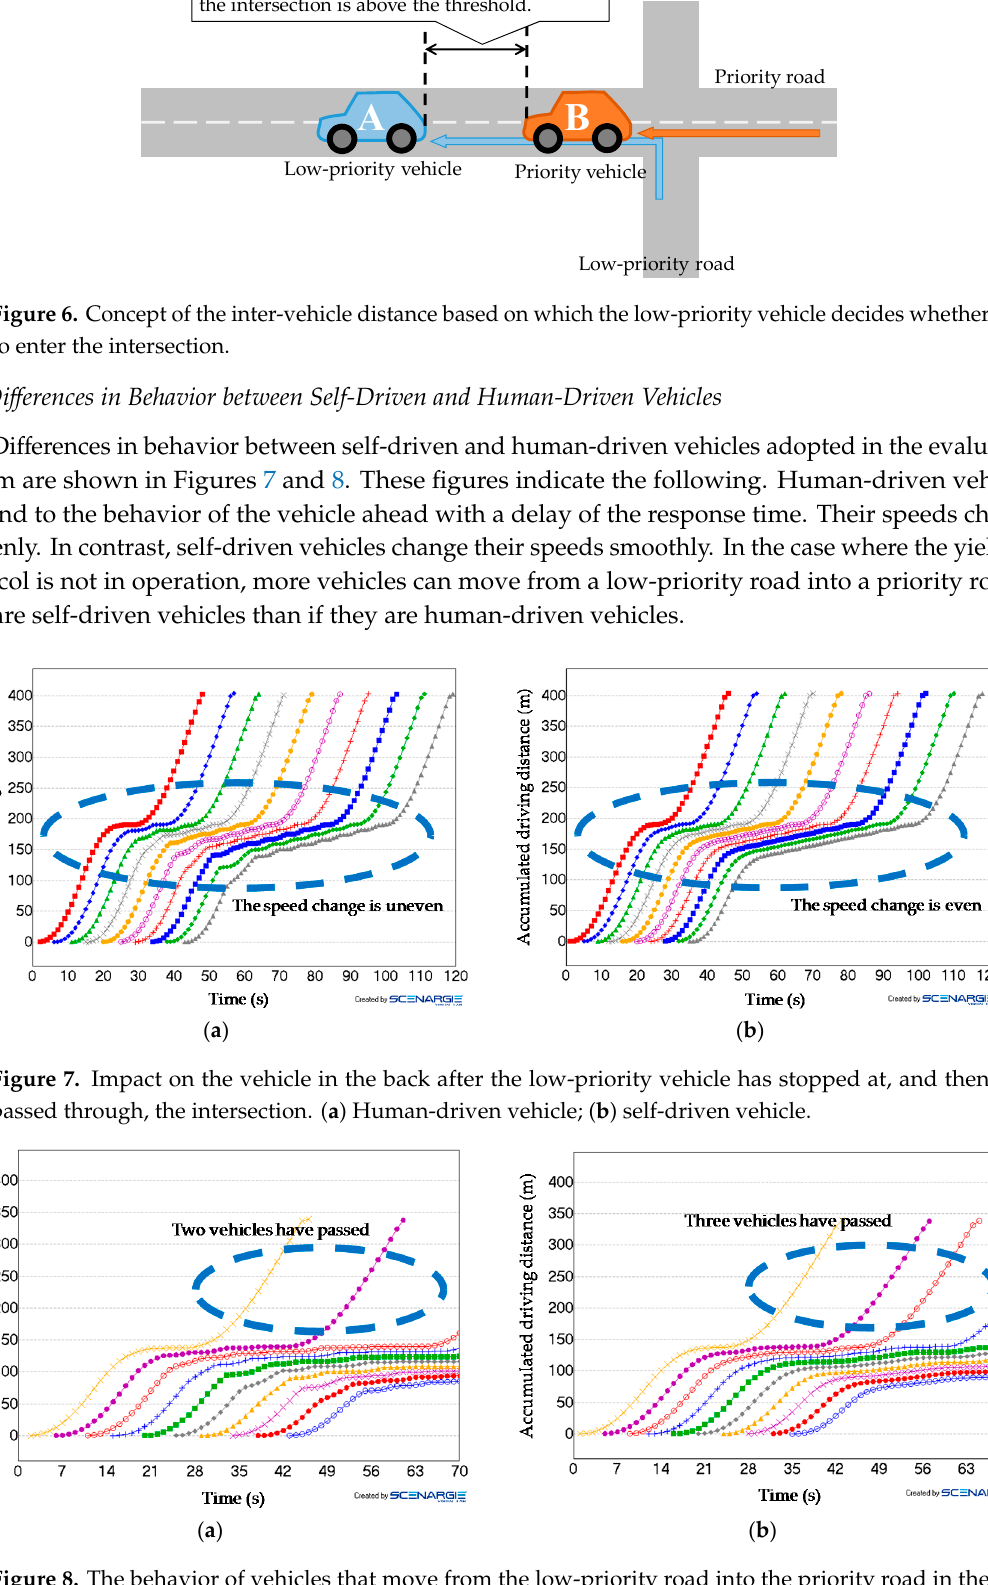
Figure 8. The behavior of vehicles that move from the low-priority road into the priority road in the case where the yielding protocol is not in operation. ( a ) Human-driven vehicle; ( b ) self-driven vehicle.